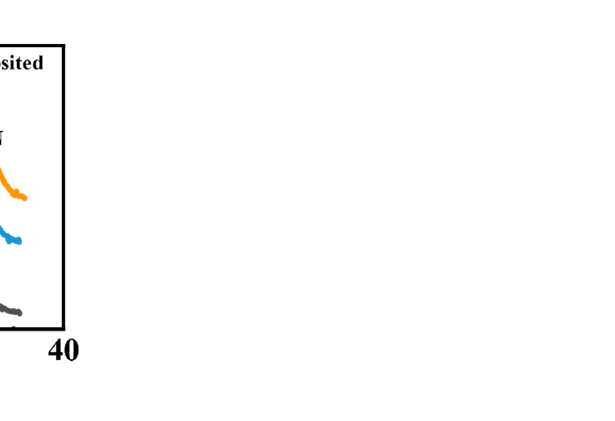
Figure 4. The GIXRD spectra of the annealed HZO films treated with MWA and RTA treatment and the as-deposited sample.